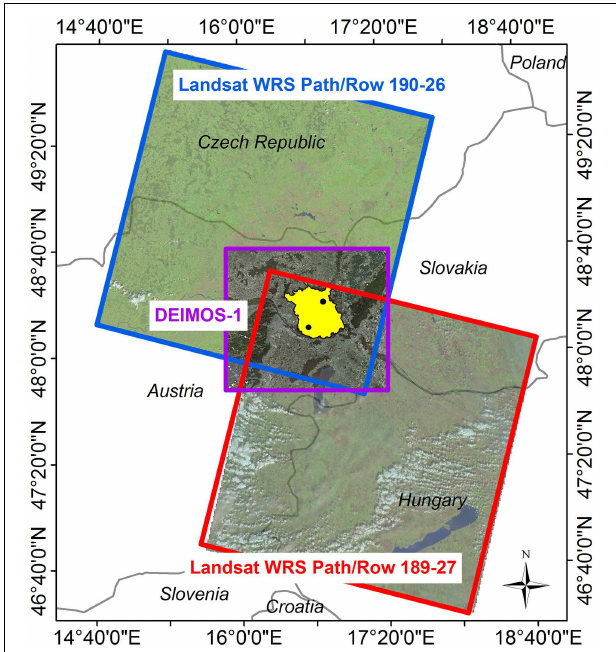
FIGURE 1 | Configuration of the Landsat-8 and DEIMOS-1 acquisitions over the test site of Marchfeld (yellow polygon). The black dots indicate the location of the two weather